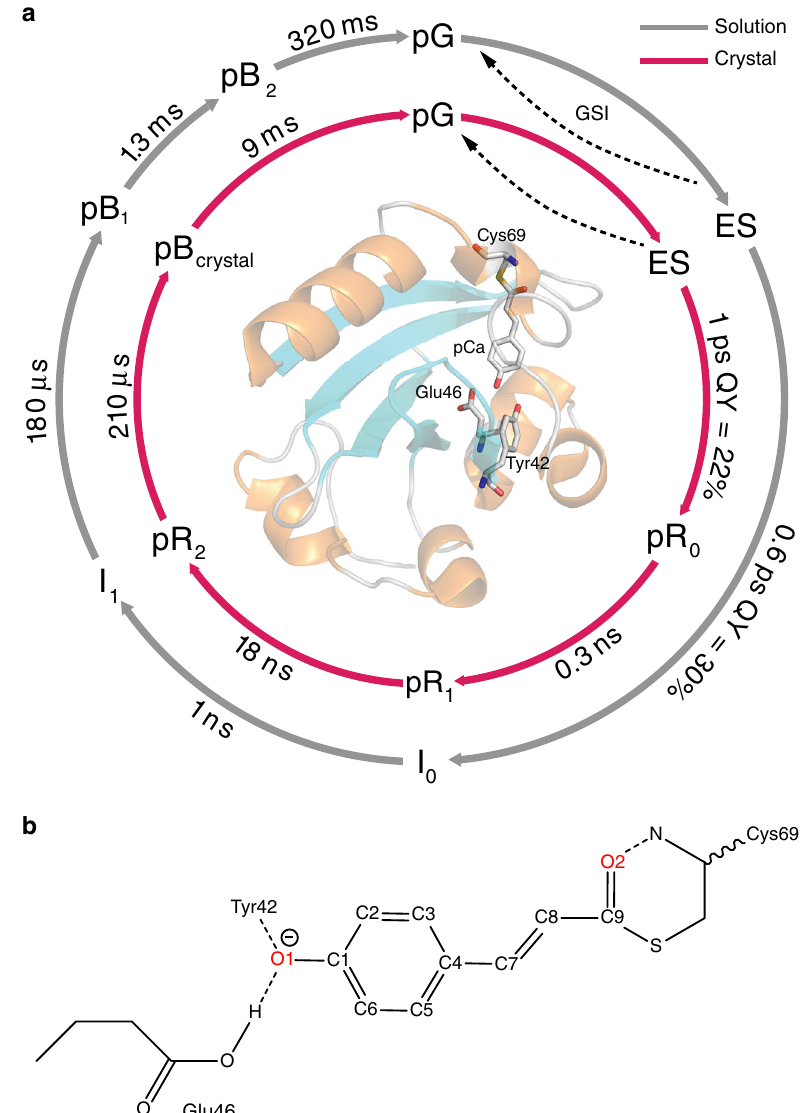
Fig. 6 Photocycle scheme of PYP in solution and in crystalline form and pCa structure. a Simpli fi ed photocycle scheme for PYP C (red arrows) and for PYP S (gray arrows). The full kinetic schemes for PYP S and PYP C are shown in Fig. 4. Upon absorption of light by pG, the excited state is formed (ES), from which pCa trans-to-cis isomerization takes place in 0.6 ps in PYP S and ~1 ps in PYP C , with quantum yields of 30 and 23% respectively. In PYP C , an additional intermediate is formed, pR 0 , followed by pR 1,2 respectively, in comparison to the intermediates (I 0,1 ) in PYP S . b pCa molecular structure in trans- con fi guration and interactions with neighboring sidechains. Hydrogen bonds are indicated by dashed